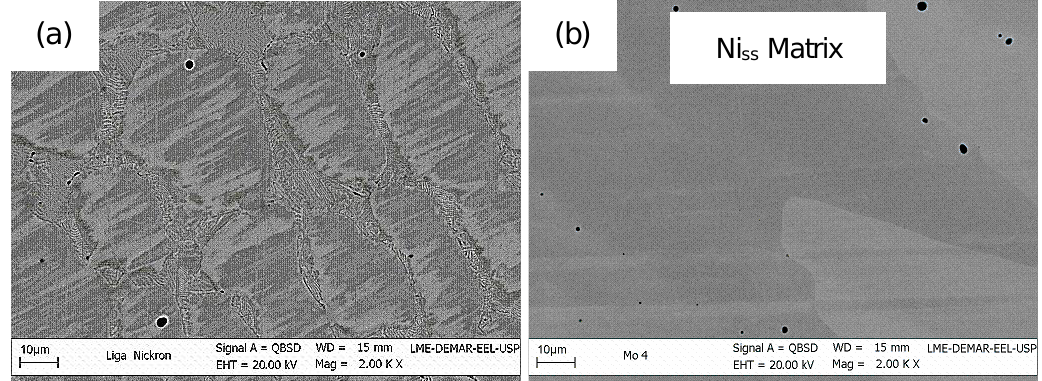
Figure 2. SEM images of the ( a ) commercial Ni-Cr alloy and ( b ) as-cast Ni-22Cr-10Mo alloy without a chemical attack.